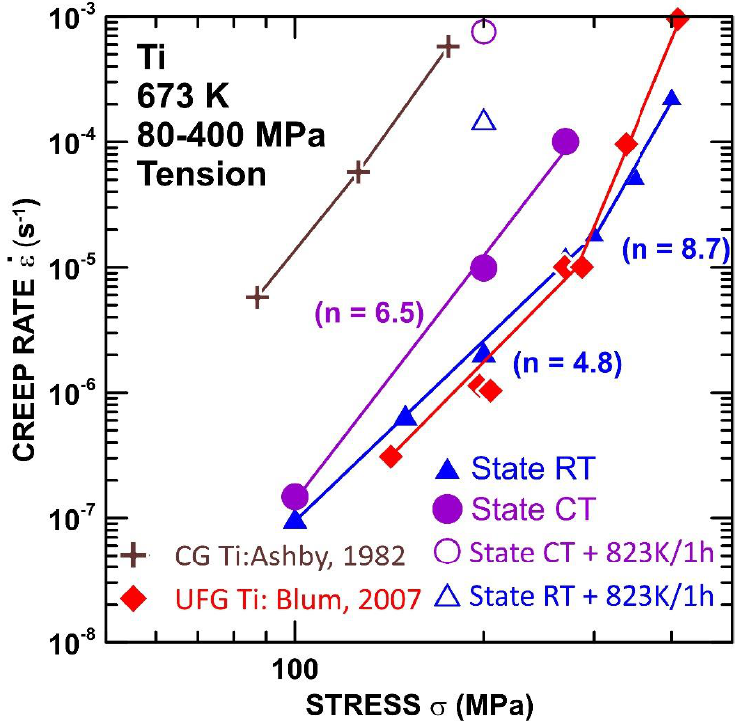
Figure 9. Comparison of the creep behaviour of titanium for different states of